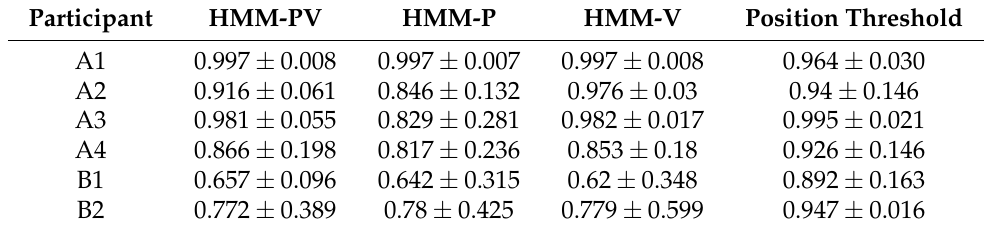
Table 1. AUC for each participant and every user intent detection